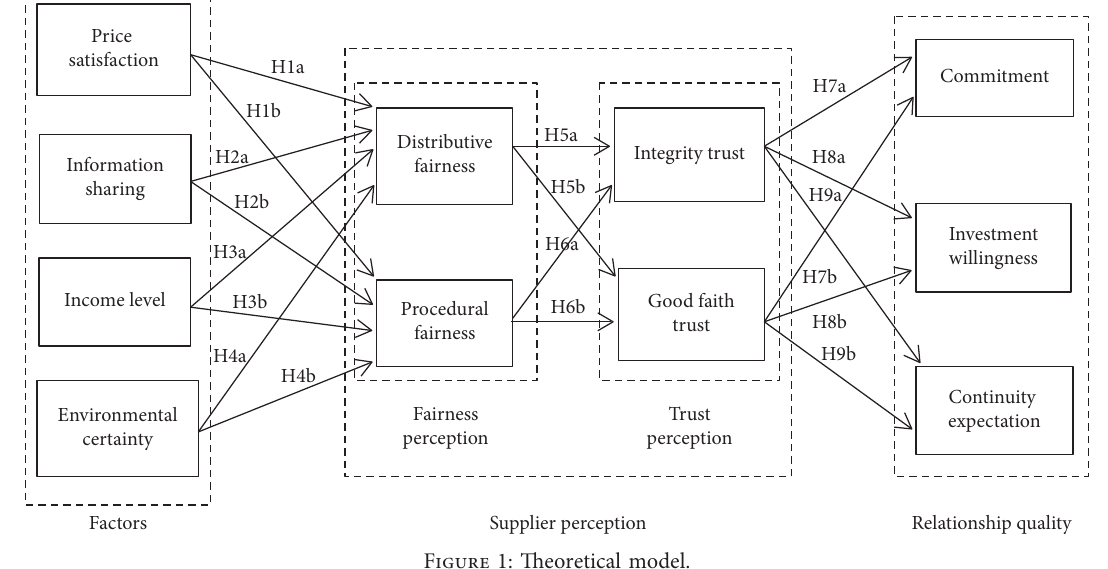
Figure 1: Theoretical